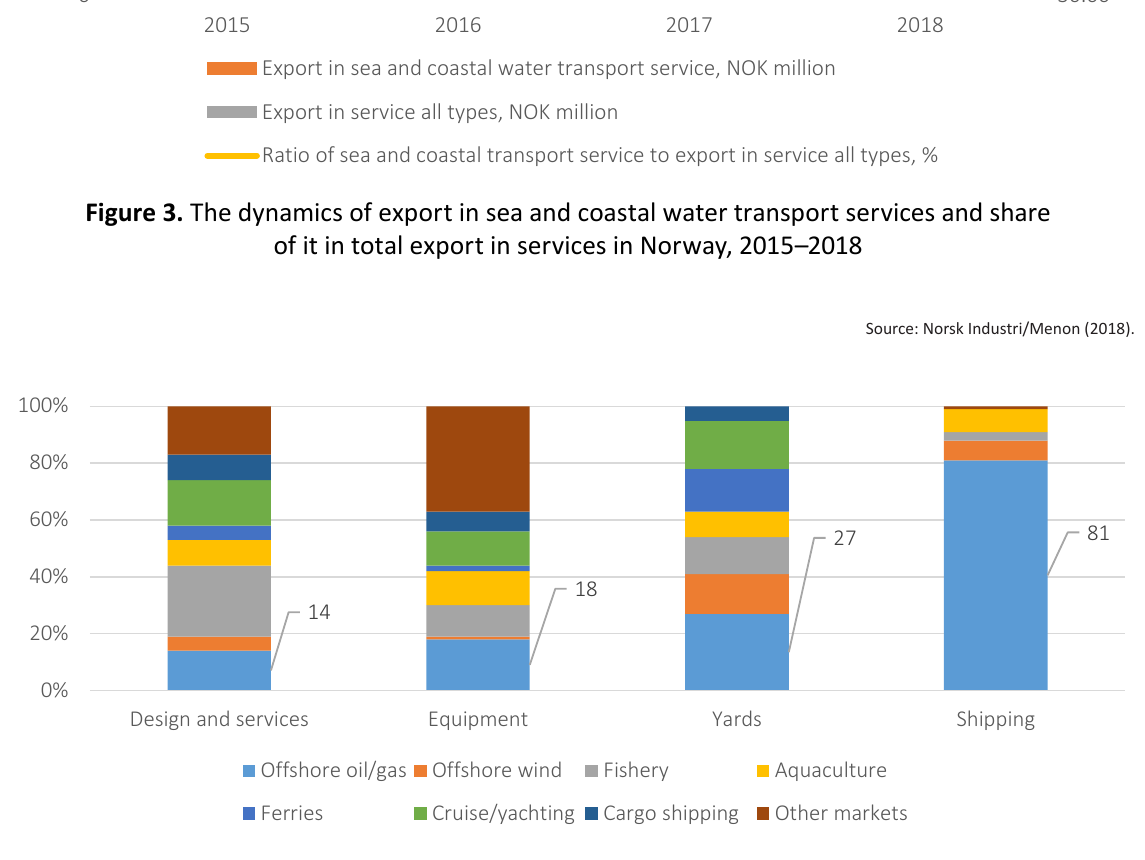
Figure 4. The cluster’s turnover broken down on the four segments and split by